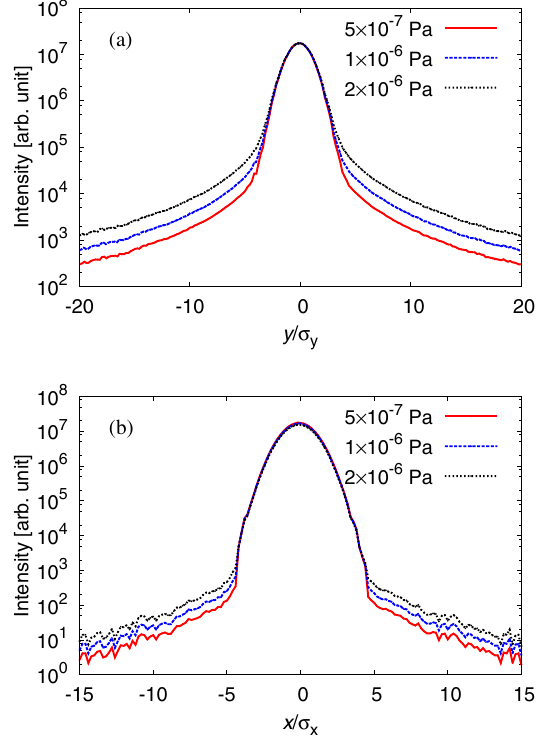
FIG. 4. Comparison of vertical (a) and horizontal (b) beam distortion between analytic approximation and simulation. A tracking time of more than 2 damping times is essential to reach the equilibrium.